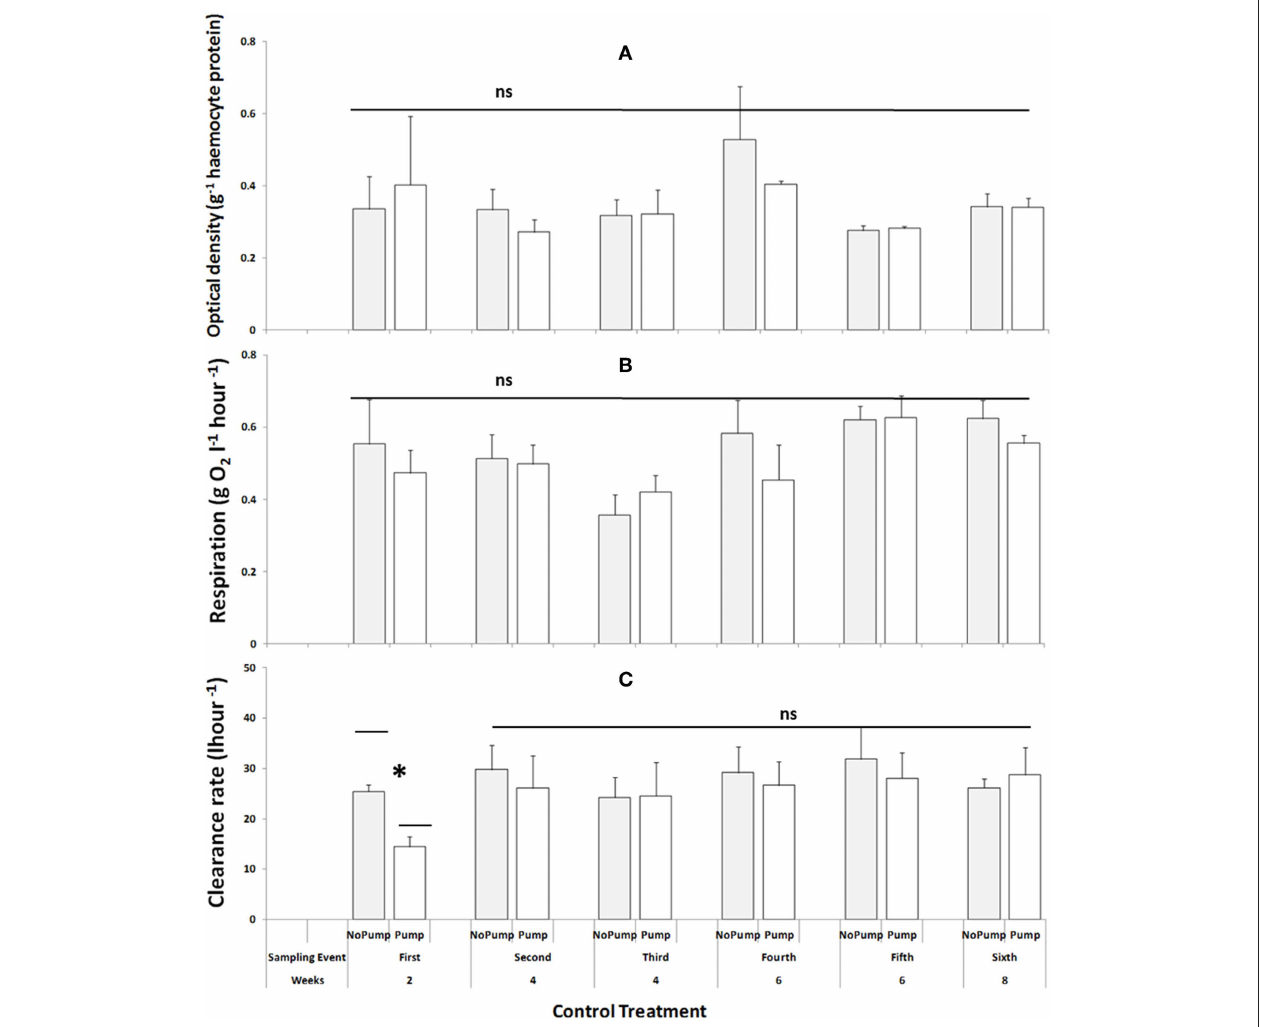
FIGURE 5 | Control treatments sampled over the duration of the experiment at Malahide marina for all three response variables; (A) Cellular viability (optical density g − 1 haemocyte protein) of mussels, (B) Respiration (mg O 2 l − 1 hour − 1 ) and (C) Clearance rate (l/hour) data of mussel assemblages. Data shown includes both control treatments: “No Pump” (an un-manipulated control) and “Pump” (a procedural control). All treatments were subject to six sampling events over the duration of the experiment, which ran for a total of eight weeks ( n = 3 plots; data are untransformed; Cochran’s test: ns). Asterisks indicate significant differences between individual and/or groups of